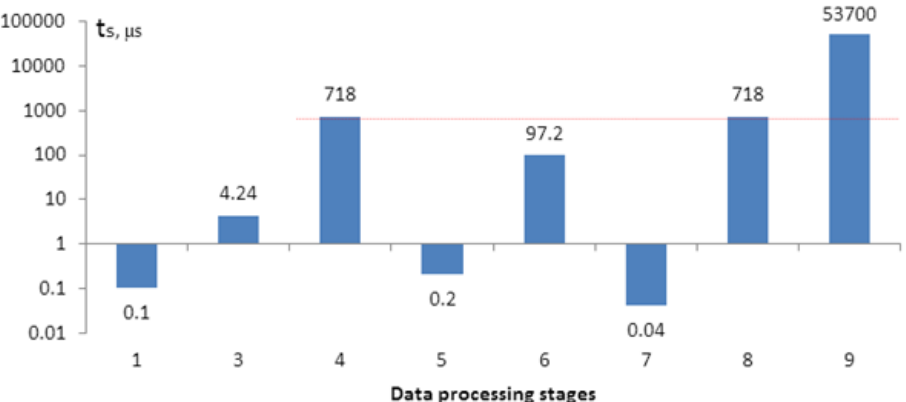
Figure 6. Data processing time on different stages in the